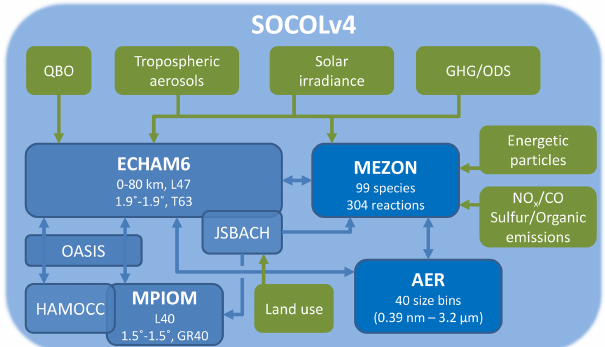
Figure 1. Components and information flow in the atmosphere– ocean–aerosol–chemistry–climate model SOCOLv4. Green boxes symbolize prescribed boundary